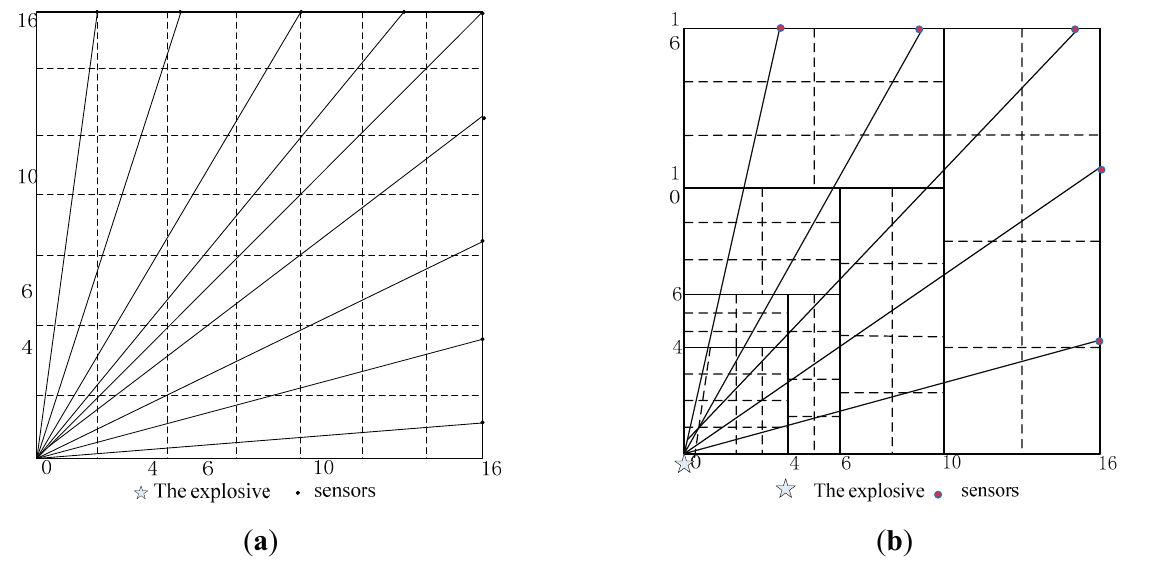
Figure 4. Two cell patterns. ( a ) Uniform rectangle cells; ( b ) Multi-scale